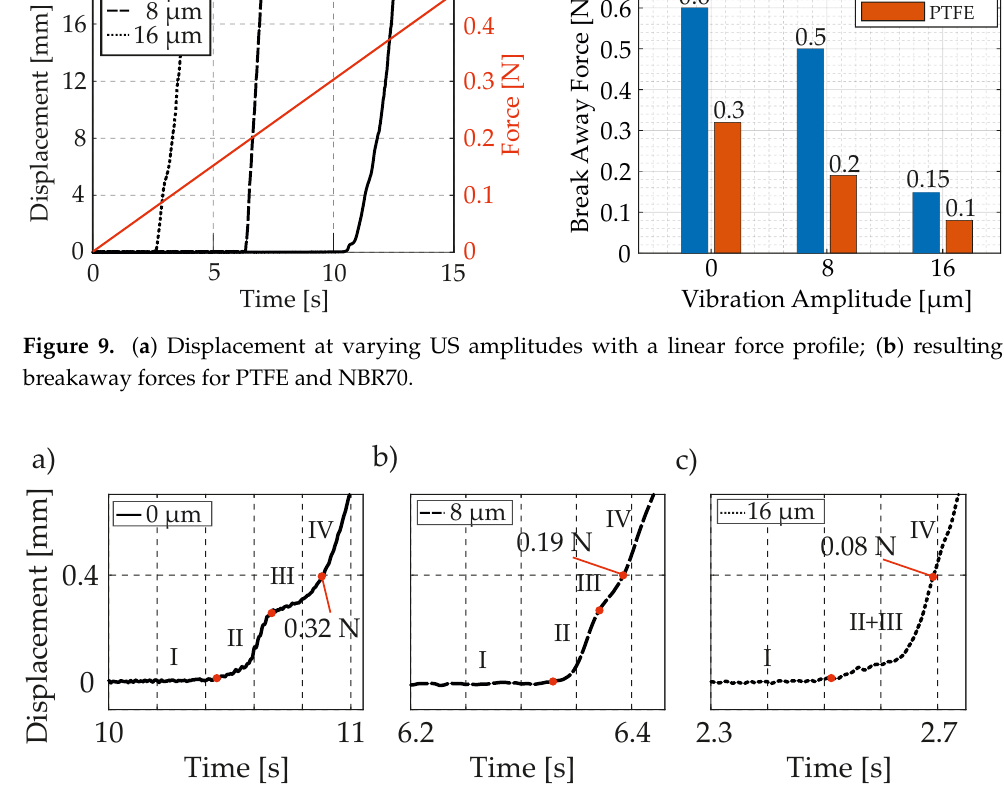
Figure 10. Breakaway phases (I–IV) in the displacement course of the PTFE sealing with a feed force increasing with 0.03 N/s for a superposed ultrasonic amplitude of 0 µm ( a ), 8 µm ( b ) and 16 µm ( c ).